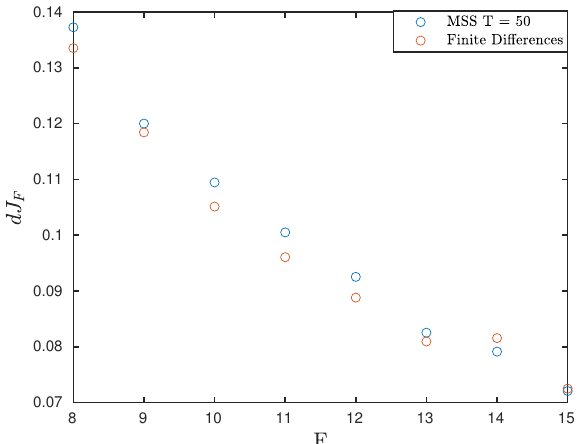
Figure 5. Comparison of sensitivities as computed by MSS and FD. The MSS was conducted for a segment of size ∆ T = 0.7, K = 35 total segments and N = 40 .